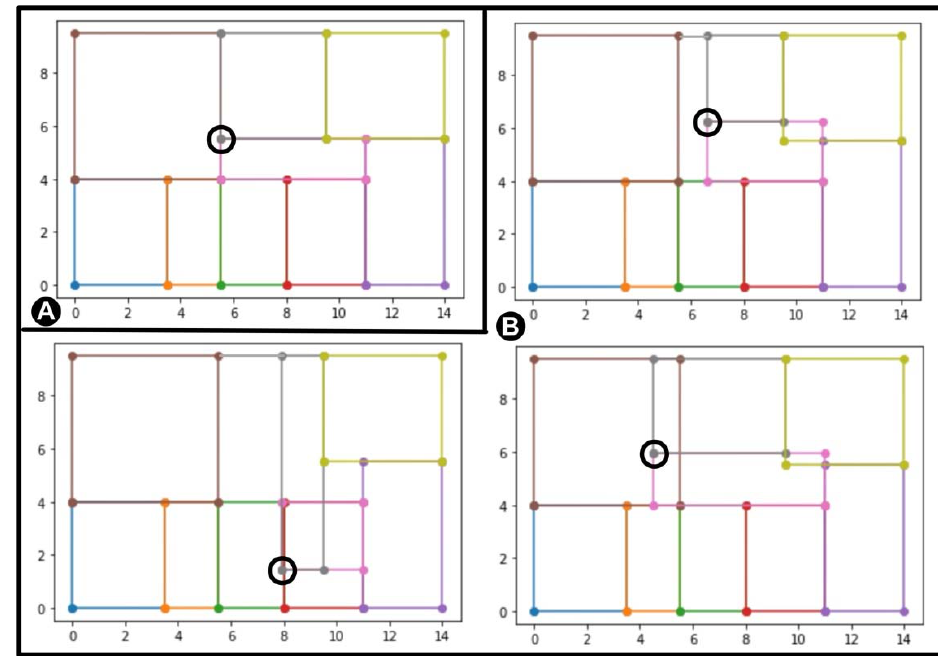
Figure 6. Moving a point mutation. (A) Selected point. (B) Three possible realizations.